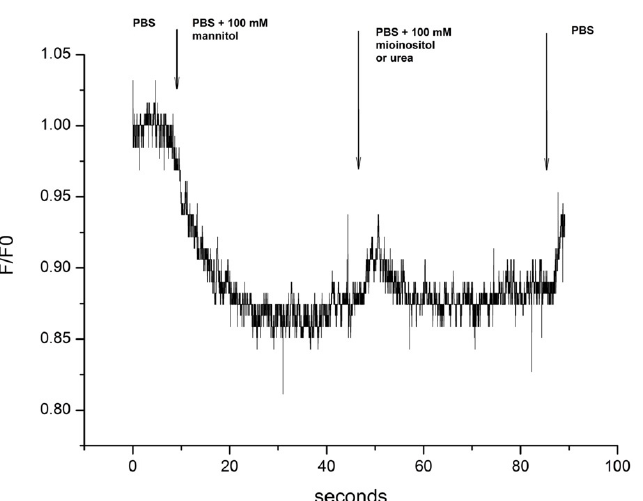
Figure 1. Schematic of the experimental design depicting the changes of the extracellular medium from PBS to PBS + 100 mM mannitol and subsequently to PBS + 100 mM of myo-inositol or urea. F/F0: Ratio of Fluorescence intensity to the initial fluorescence at time 0